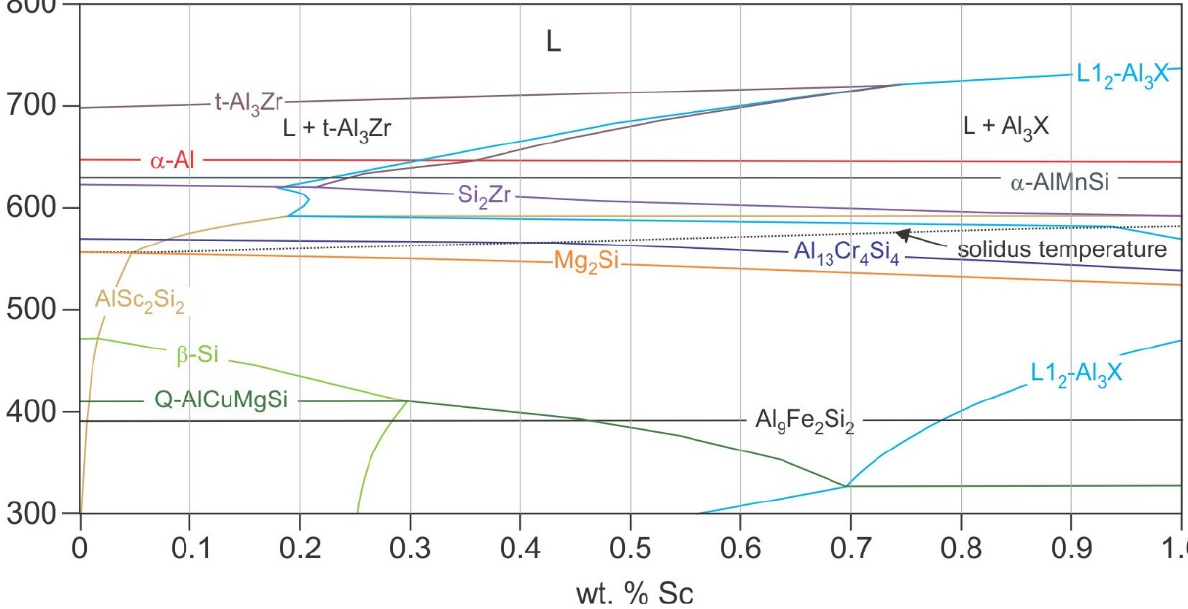
Figure 1. The effect of Sc on the liquidus temperature and formation of phases in the Al corner of the AA 6086 alloy. The vertical section was calculated by Thermo-Calc Software.